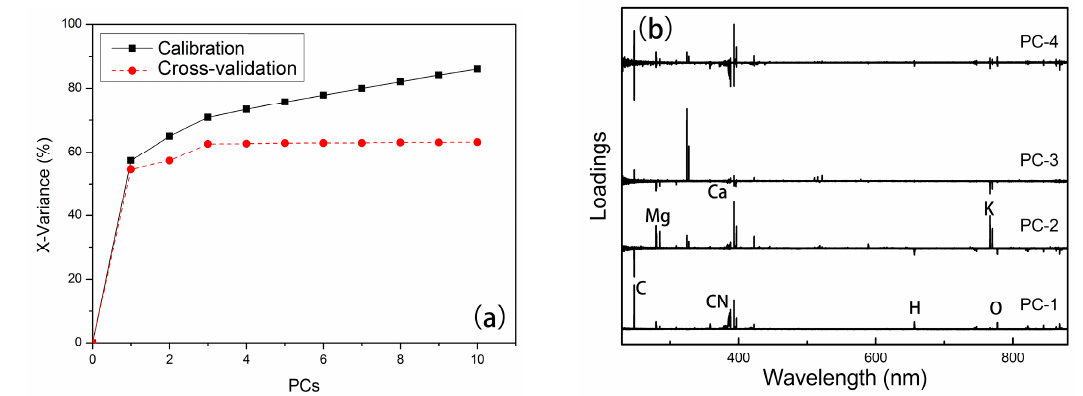
Figure 3. Results of PCA. ( a ) Explanation of X-variance; and ( b ) PCA loadings of PC1-PC4.